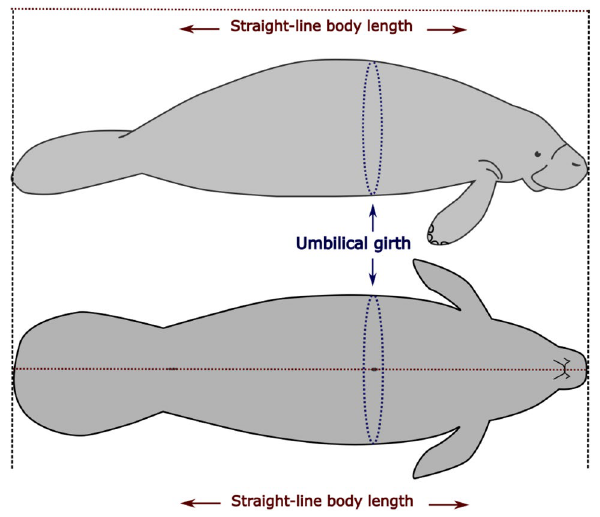
Figure 1. Illustration of straight-line total length (SL) and umbilical girth (UG) measured in wild and captive Antillean